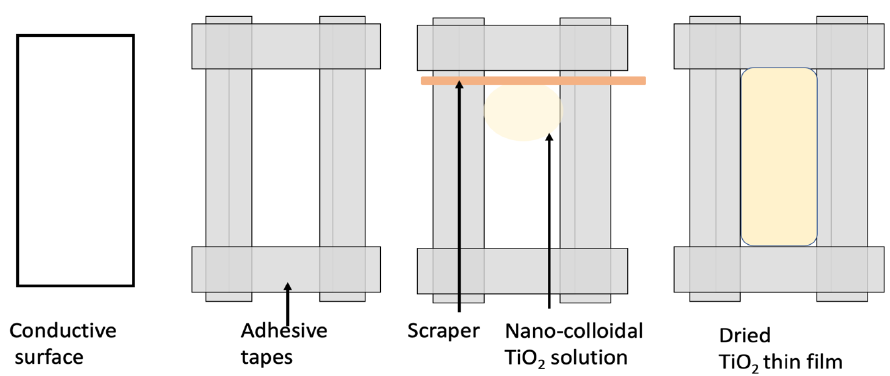
Figure 14. Schematics of doctor blade method.